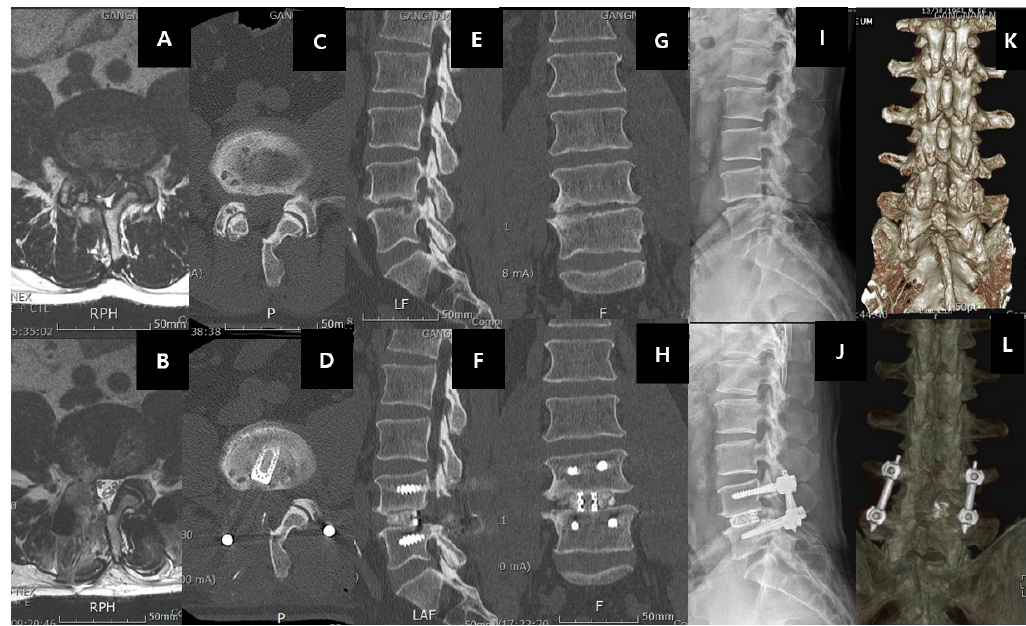
Figure 7. Right-sided L4/5 recurrent disc herniation after previous open laminotomy and discectomy 2 years ago, the patient underwent uniportal endoscopic transforaminal lumbar interbody fusion of right L4/5(ETLIF). A shows the recurrence of disc herniation with facet arthritis in the MRI axial cut of L4/5. B shows the same axial cut with left transforaminal lumbar interbody fusion showing resection of the facet joint and cage in an optimal position. C and D show the pre and post-operative status of the right facet. Note the previous right L4 laminotomy in C , the facet was resected, and the cage introduced in an optimal position as shown in D . E and F show the sagittal view of the pre and pos-operative status. Note the increase in the foraminal height and intervertebral height as a result of the right L4/5 ETLIF. G and H show the increase in the coronal disc height pre and post-operatively in right L4/5 ETLIF. I and J show the pre and post-operative standing neutral XR with the L4/5 interbody cage and standard posterior inserted pedicle screws in L4 and L5. K and L show the 3D reconstruction of pre and post-operative right L4/5 ETLIF.